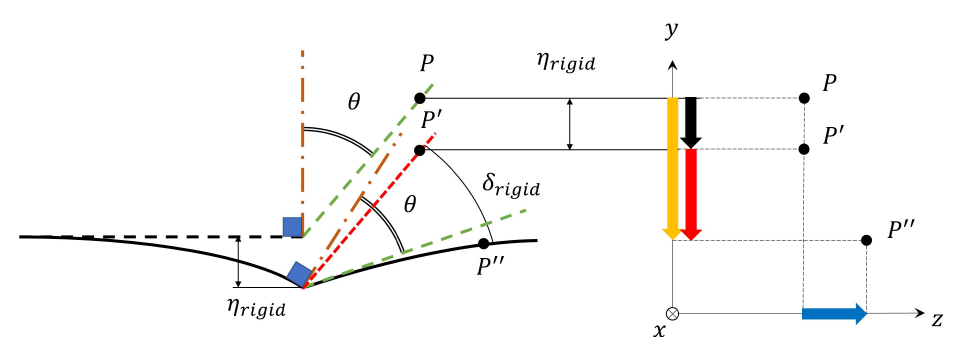
Figure 1. Scheme of the deformation of the assembly (structure + main supports). Here, P is the theoretical position of a given point in the gantry. P (cid:48)(cid:48) is the real position due to the deformations of the structure and